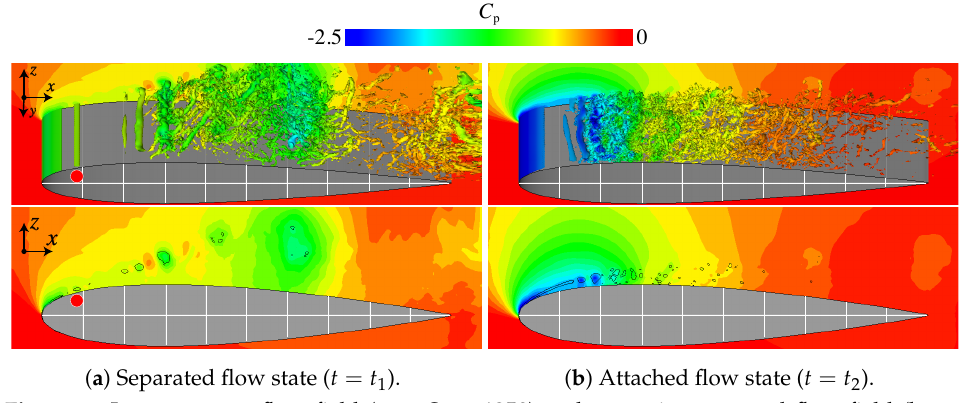
Figure 9. Instantaneous flow field (top, Q = 1250) and spanwise-averaged flow field (bottom, Q = 250) with isosurfaces of the second invariant of the velocity gradient tensor ( Q ) colored based on the pressure coefficient ( C p ) in FTM1 at α = 12. The red circles denote the locations of representative spanwise